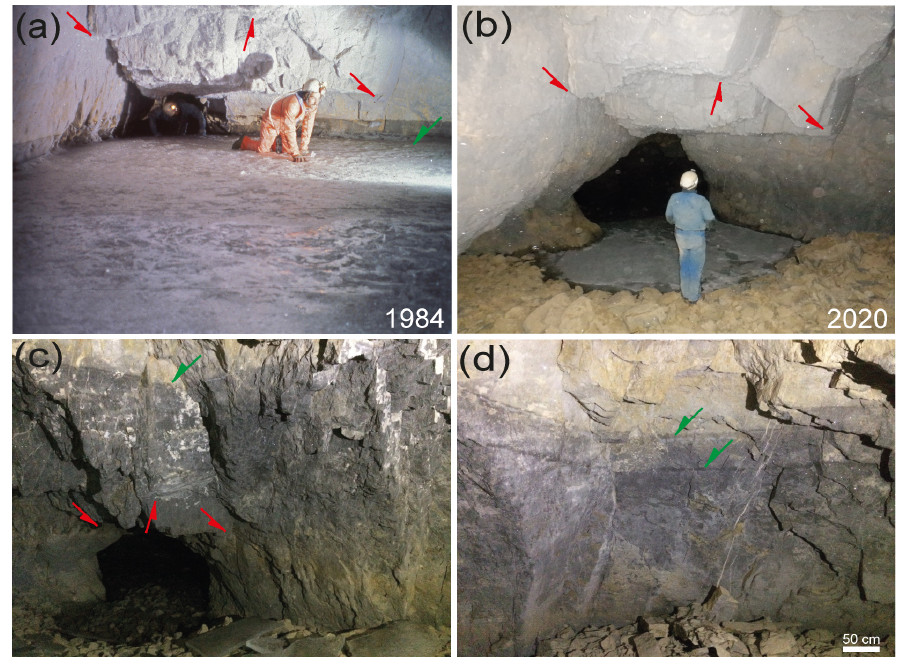
Figure 8. (a) Photo taken close to the river sector that connects rooms F and E. The estimated ice level is 5m higher than the Brulle spring. Photo by Jean Luc Bernardin (8 August 1984). (b) Similar area in 2020, as well as the maximum extension of the seasonal lake ice formed during winter. (c) Higher ice mark level (ca. + 9.5m with respect to the Brulle spring) and remnants of ice sheets from the frozen lake in 2018. (d) Two ice-level marks (ca. + 9.2 and + 8.8m with respect to the Brulle spring) located between the highest mark and the elevation of the ice in photo (a) . In all images red arrows indicate the same rock edges, while green arrows show ice-level